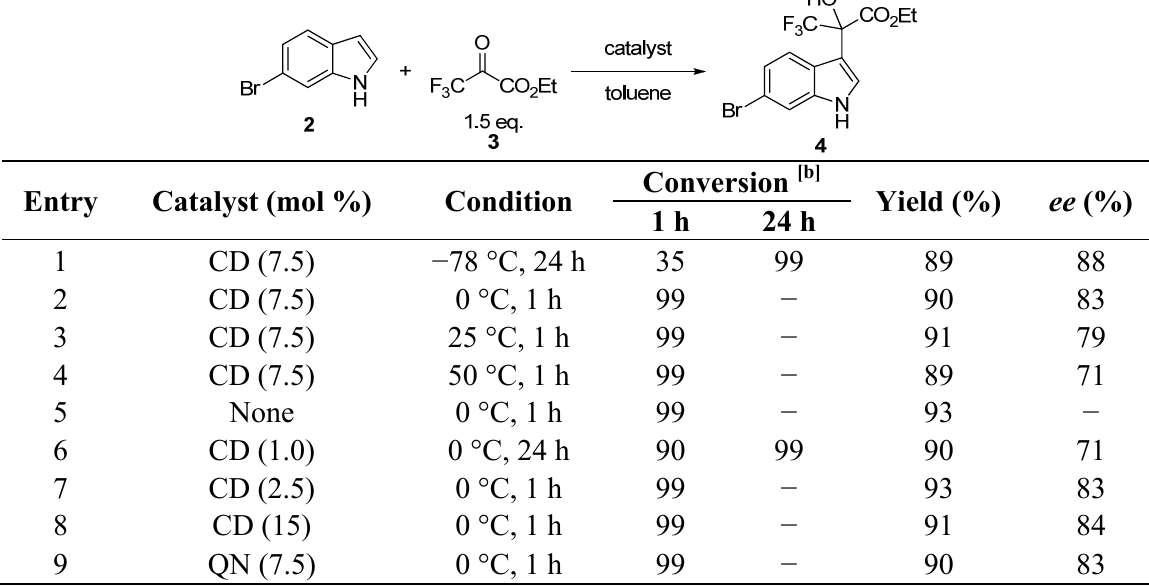
Table 2. Optimization of reaction temperature and the amount of catalysts in toluene [ a ]